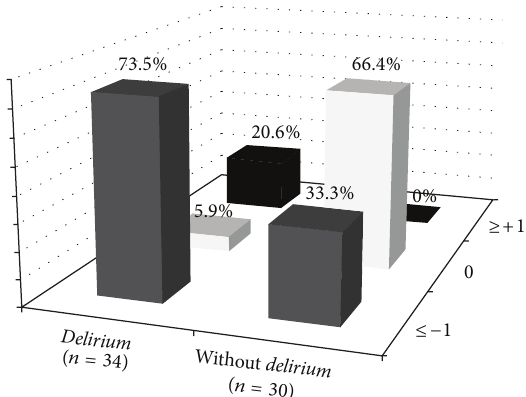
Figure 3: Worst agitation-drowsiness (RASS) values during CAM- ICU assessment ( 𝑛 = 64 ). Richmond Agitation Sedation Scale (RASS) value ≤ 1 indicates deepest drowsiness, while value ≥ 1 indicates psychomotor agitation. CAM-ICU: confusion assessment method for the ICU .